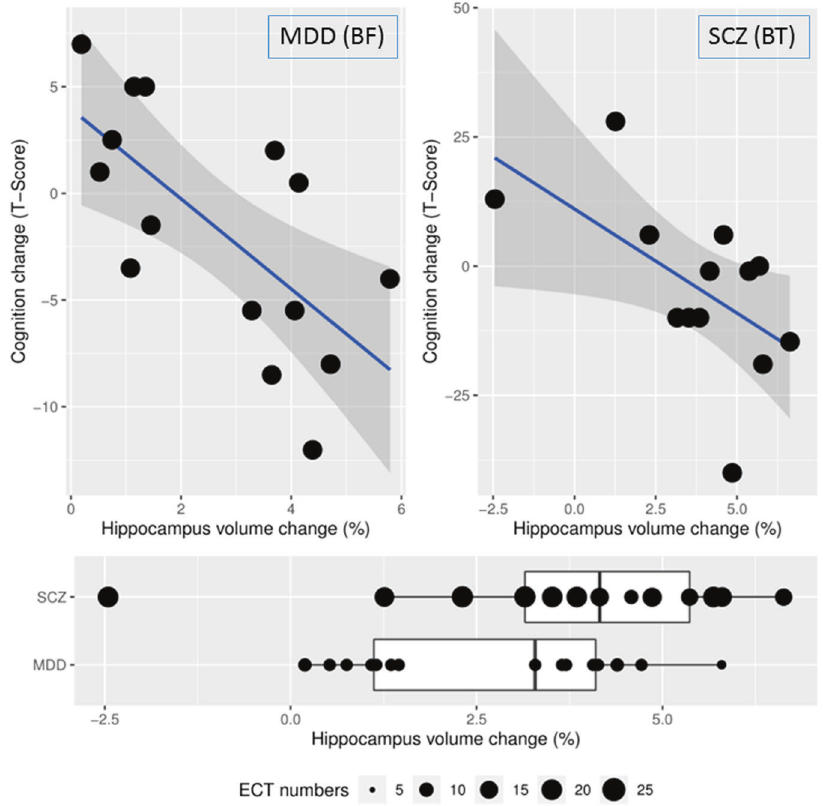
Fig. 3 The relationship between hippocampus volume change and cognitive performance change. Left upper panel: Cohort with MDD patients and BF electrode placement, r = − 0.68, df = 13, p = 0.005. Right upper panel: Cohort with schizophrenia patients and BT electrode placements, r = − 0.58, df = 11, p = 0.04, (one individual could not participate in baseline cognitive testing). Lower panel: Patients with depression had on average 8.0 ± 0.6 ECTs between image acquisitions showed an average of 2.68% increase in hippocampal volume, patients with schizophrenia, who had on average 17.3 ± 3.4 ECTs between image acquisitions showed an average of 4.43% increase in hippocampus